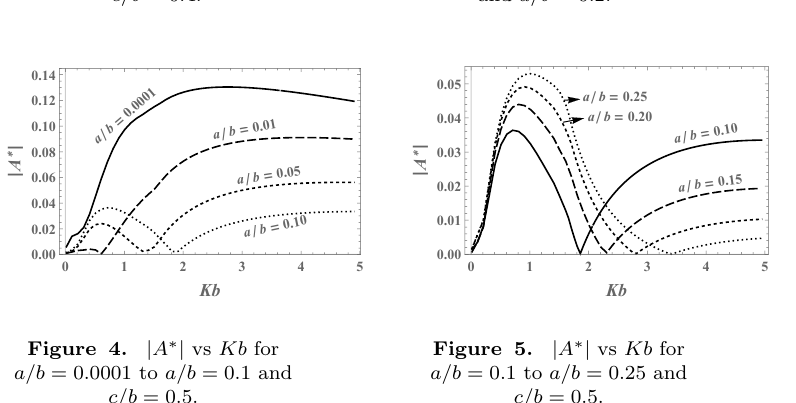
Figure 5. | A ∗ | vs Kb for a/b = 0 . 1 to a/b = 0 . 25 and c/b = 0 . 5